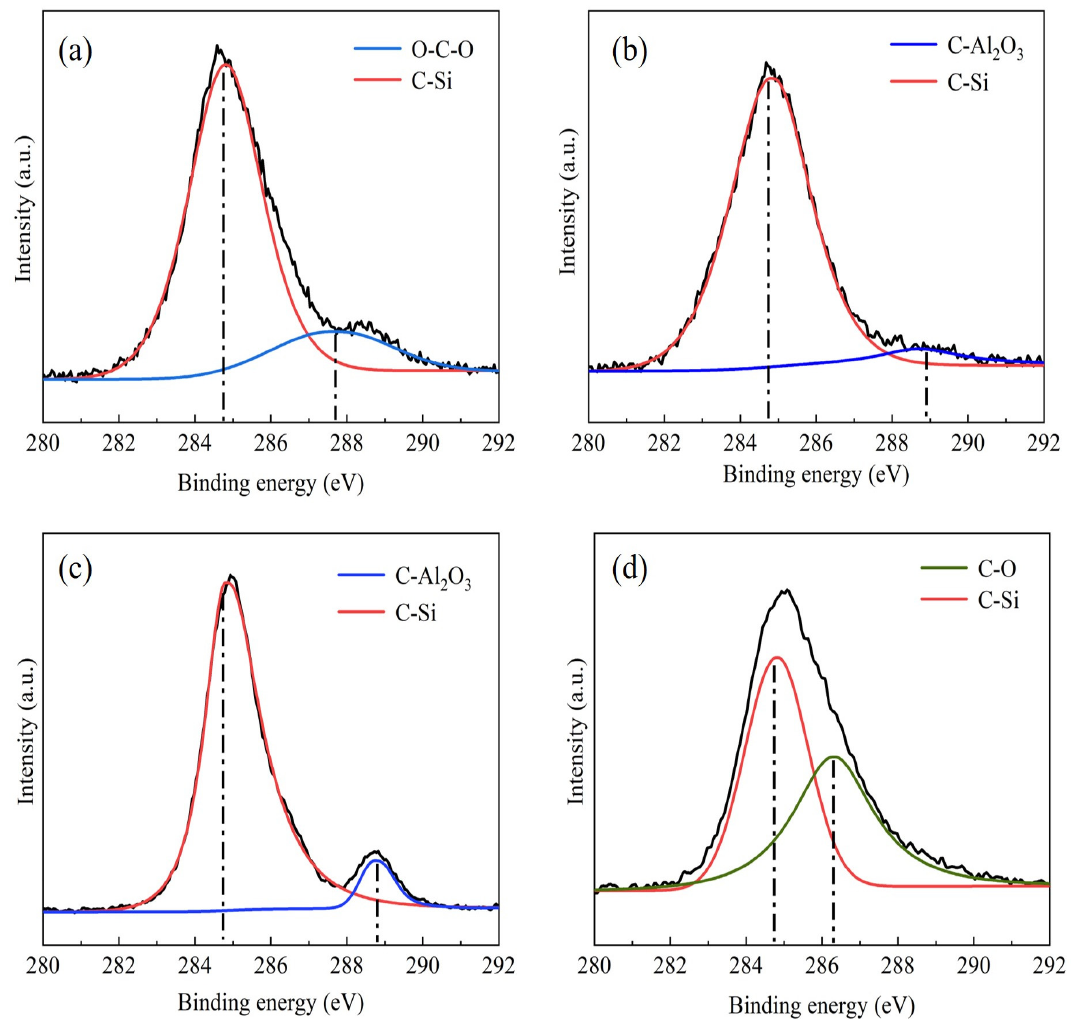
Figure 2. C 1s XPS spectra of Al 2 O 3 /C mixed powder with different contents of dispersants: ( a ) 2.5 wt%, ( b ) 5 wt%, ( c ) 7.5 wt%, ( d ) 10 wt%.